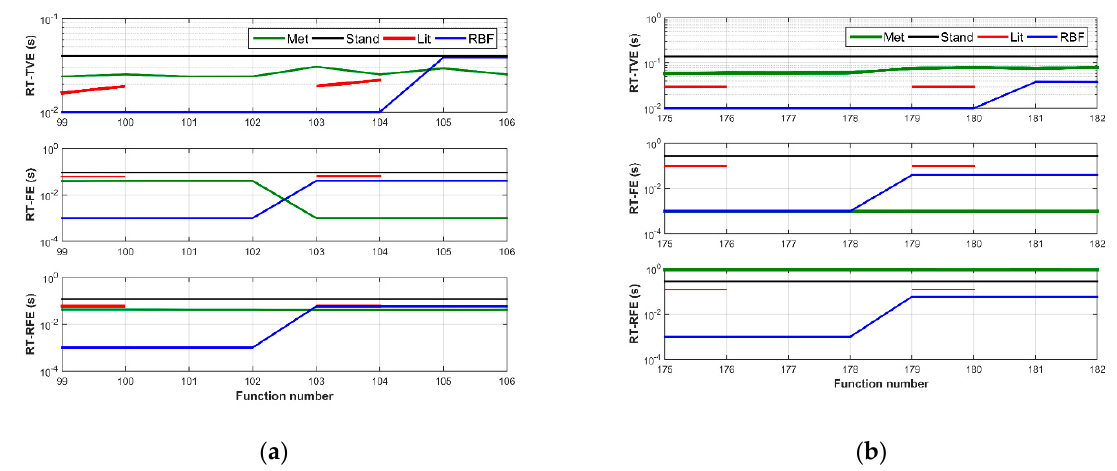
Figure 5. The RT-TVE, RT-FE and RT-RFE graphs for subsequent functions: ( a ) data for the P class of the PMU device; ( b ) data for the M class of the PMU device.